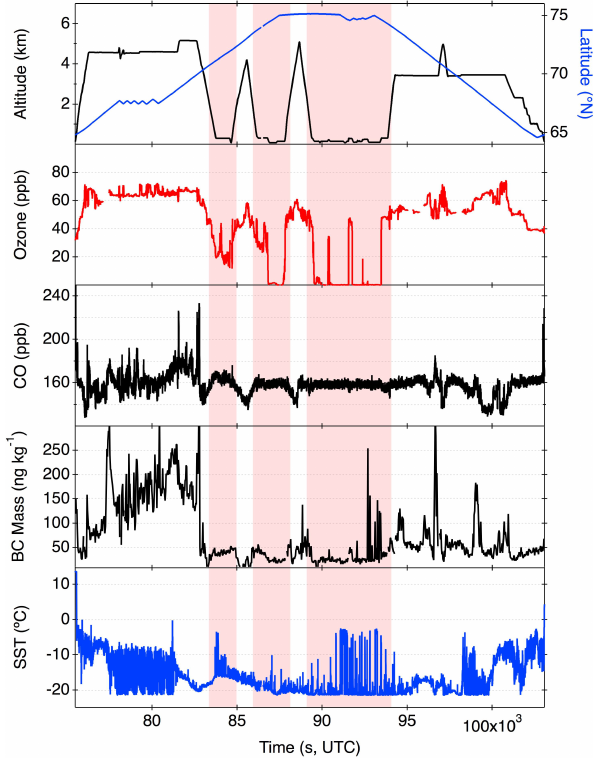
Fig. 5. Time series of altitude, latitude, ozone, CO, BC mass, and SST for the flight of 12 April 2008. The shaded segments highlight the parts of the flight where the NOAA WP-3D aircraft profiled the lowest 2km altitude over the sea-ice and open